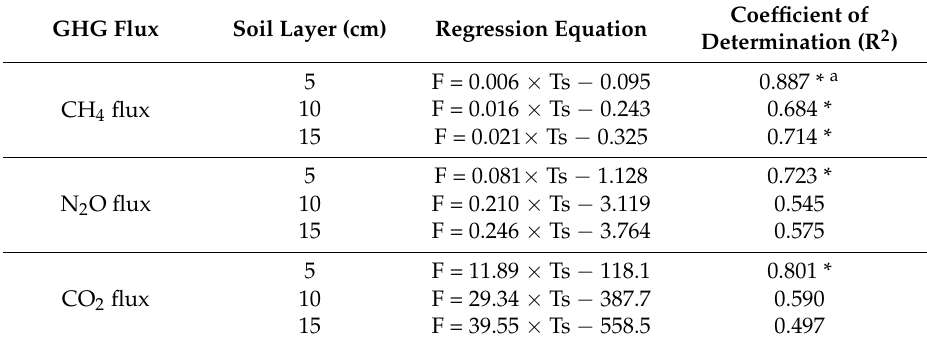
Table 2. Regression equations between daily mean greenhouse gas (GHG) flux (mg m − 2 h − 1 , F) and soil temperature ( ◦ C, Ts) at different soil layers up to 25 cm soil depth, GHG flux responses to soil temperature in a positive linear